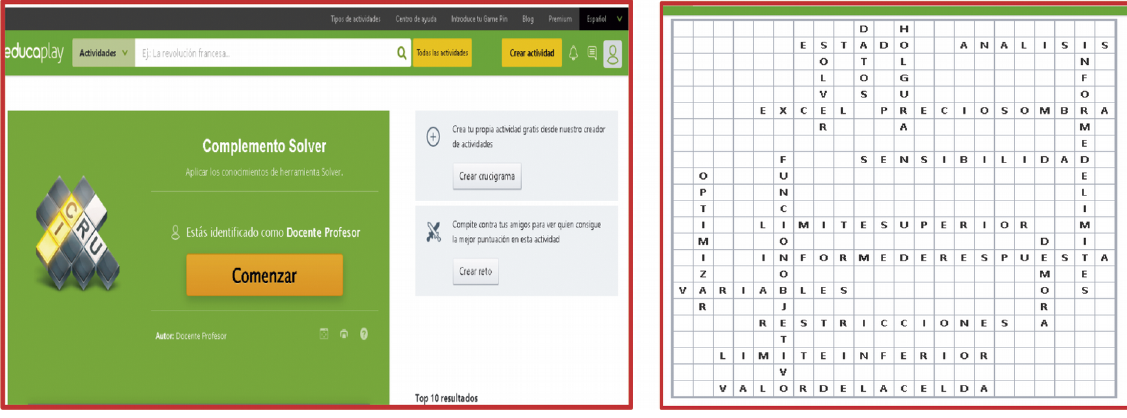
Figure 10. Solver crossword puzzle